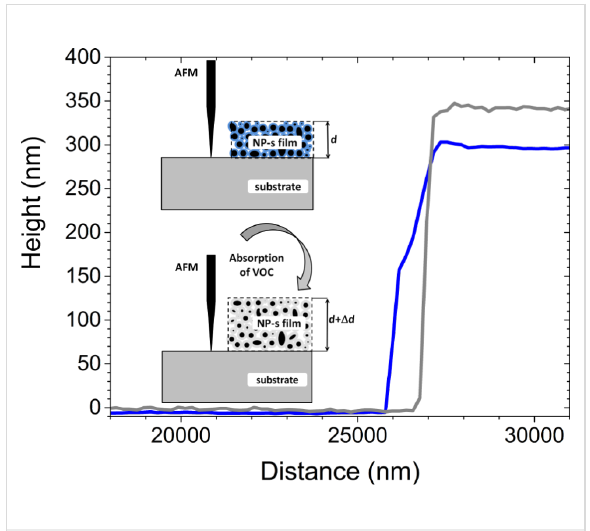
Figure 5: Left: schematic diagram of height profile measurements before and after absorption of ethanol. Right: AFM height profile of the NP-based thin film before (blue) and during exposure (grey) to ethanol vapors.